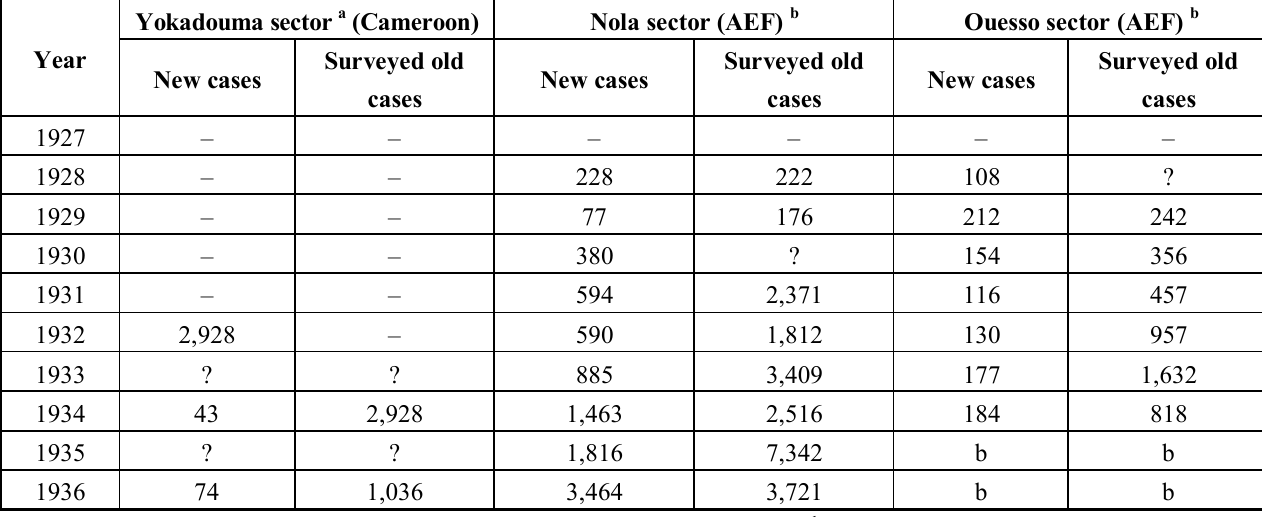
Table 3. Systematic treatments against human African trypanosomiasis (HAT) in southeast Cameroon and neighboring districts of Afrique Équatoriale Française (AEF), up to 1936. Dashes indicate no systematic activity, according to the reports. Some of the old cases were also treated. Sources: [50,51,87–97].